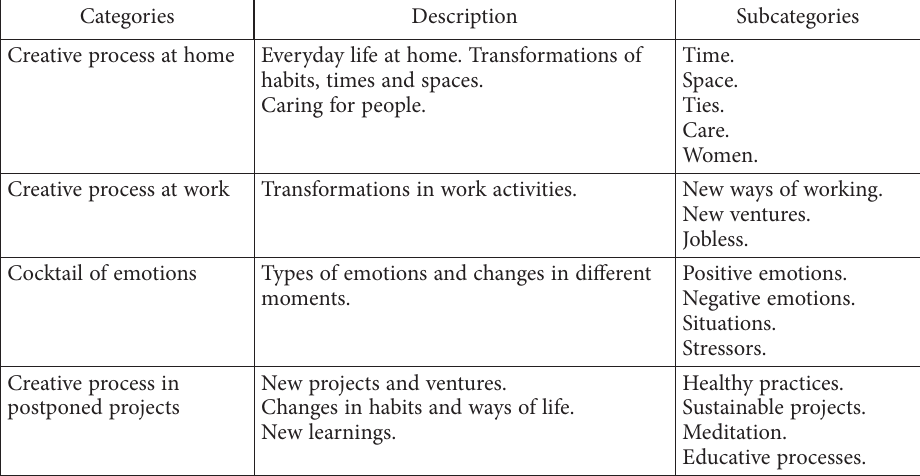
Table 1. Description of categories and subcategories (source: created by